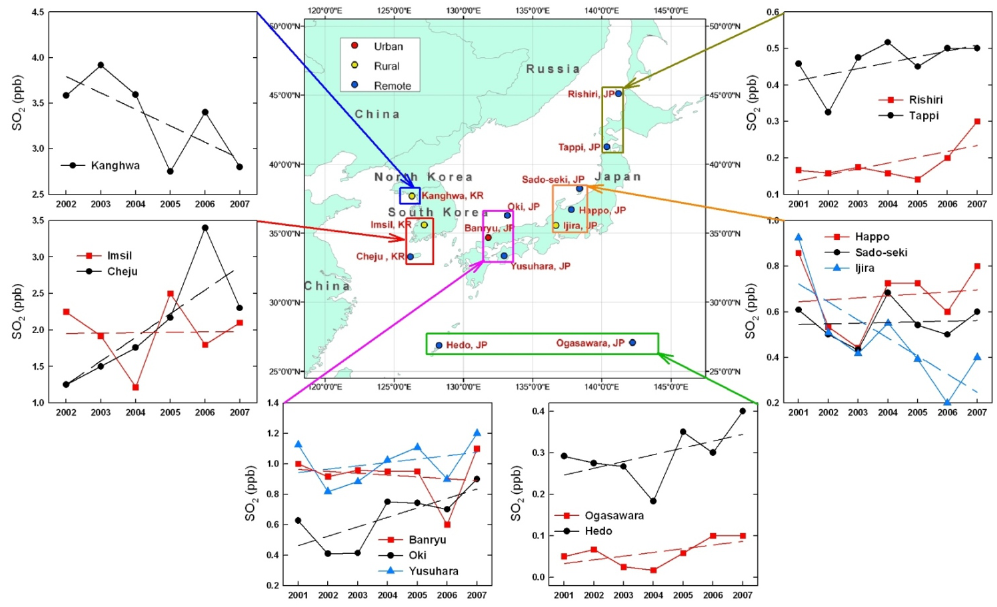
Fig. 11. Inter-annual trends of SO 2 at 13 EANET sites from 2001 to 2007. Dashed lines represent the linear